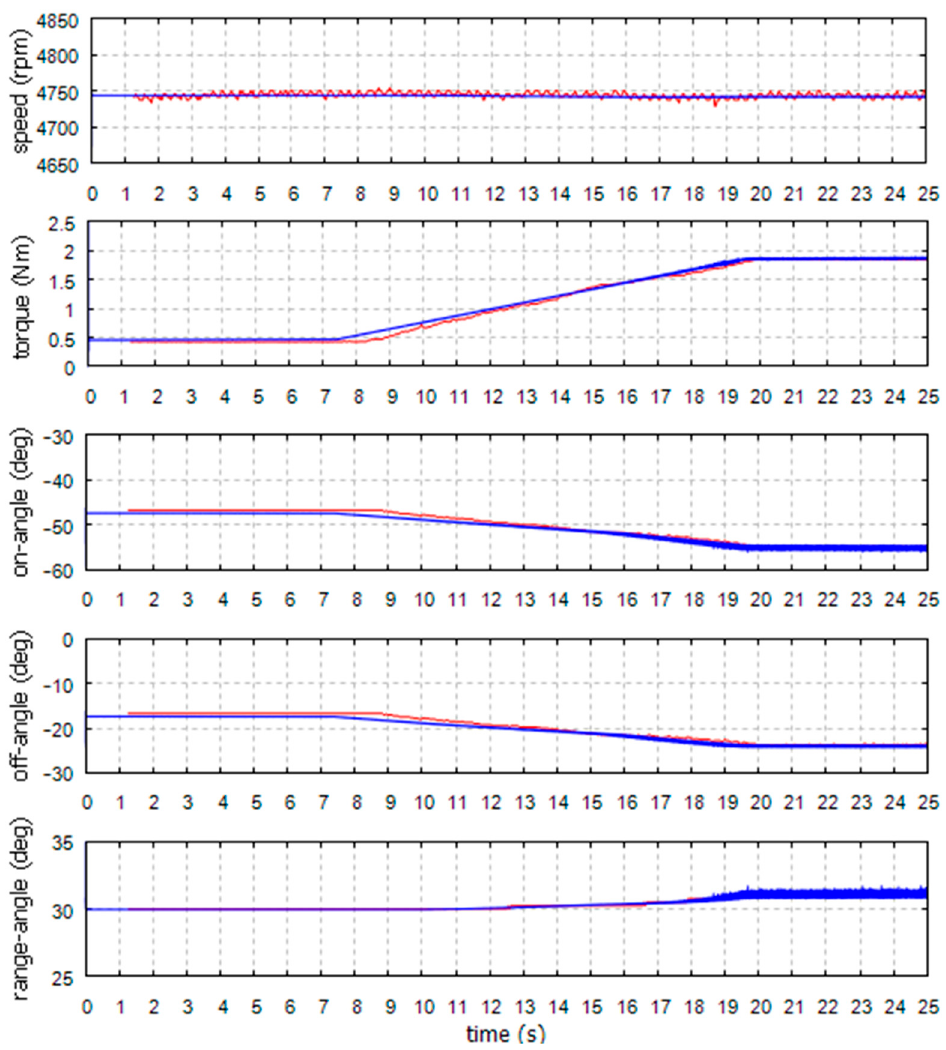
Figure 12. Load torque waveforms and corresponding values of commutation angles with load changes at constant rotational speed.